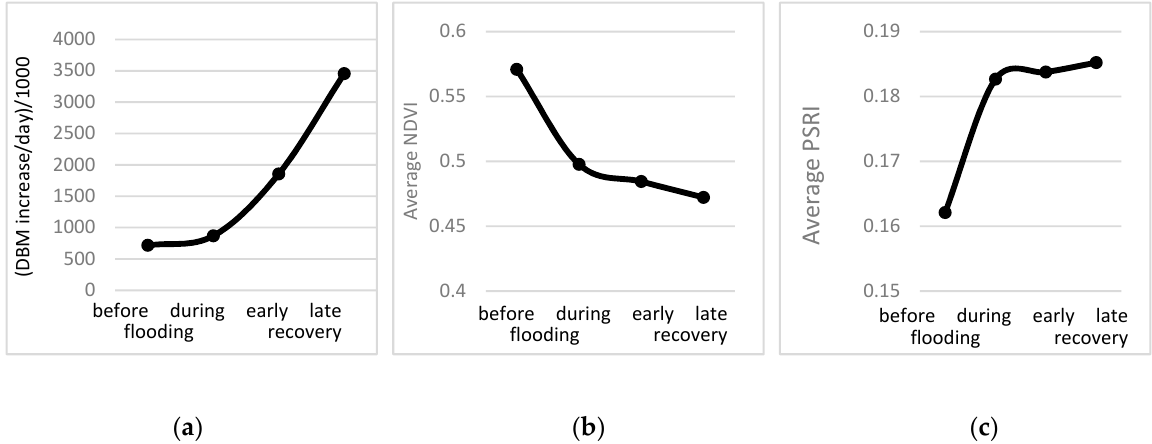
Figure 3. ( a ) Average DBM increments per day, ( b ) average NDVI, and ( c ) average PSRI of the germplasm and the control genotypes before and during flooding, as well as during early and late recovery.